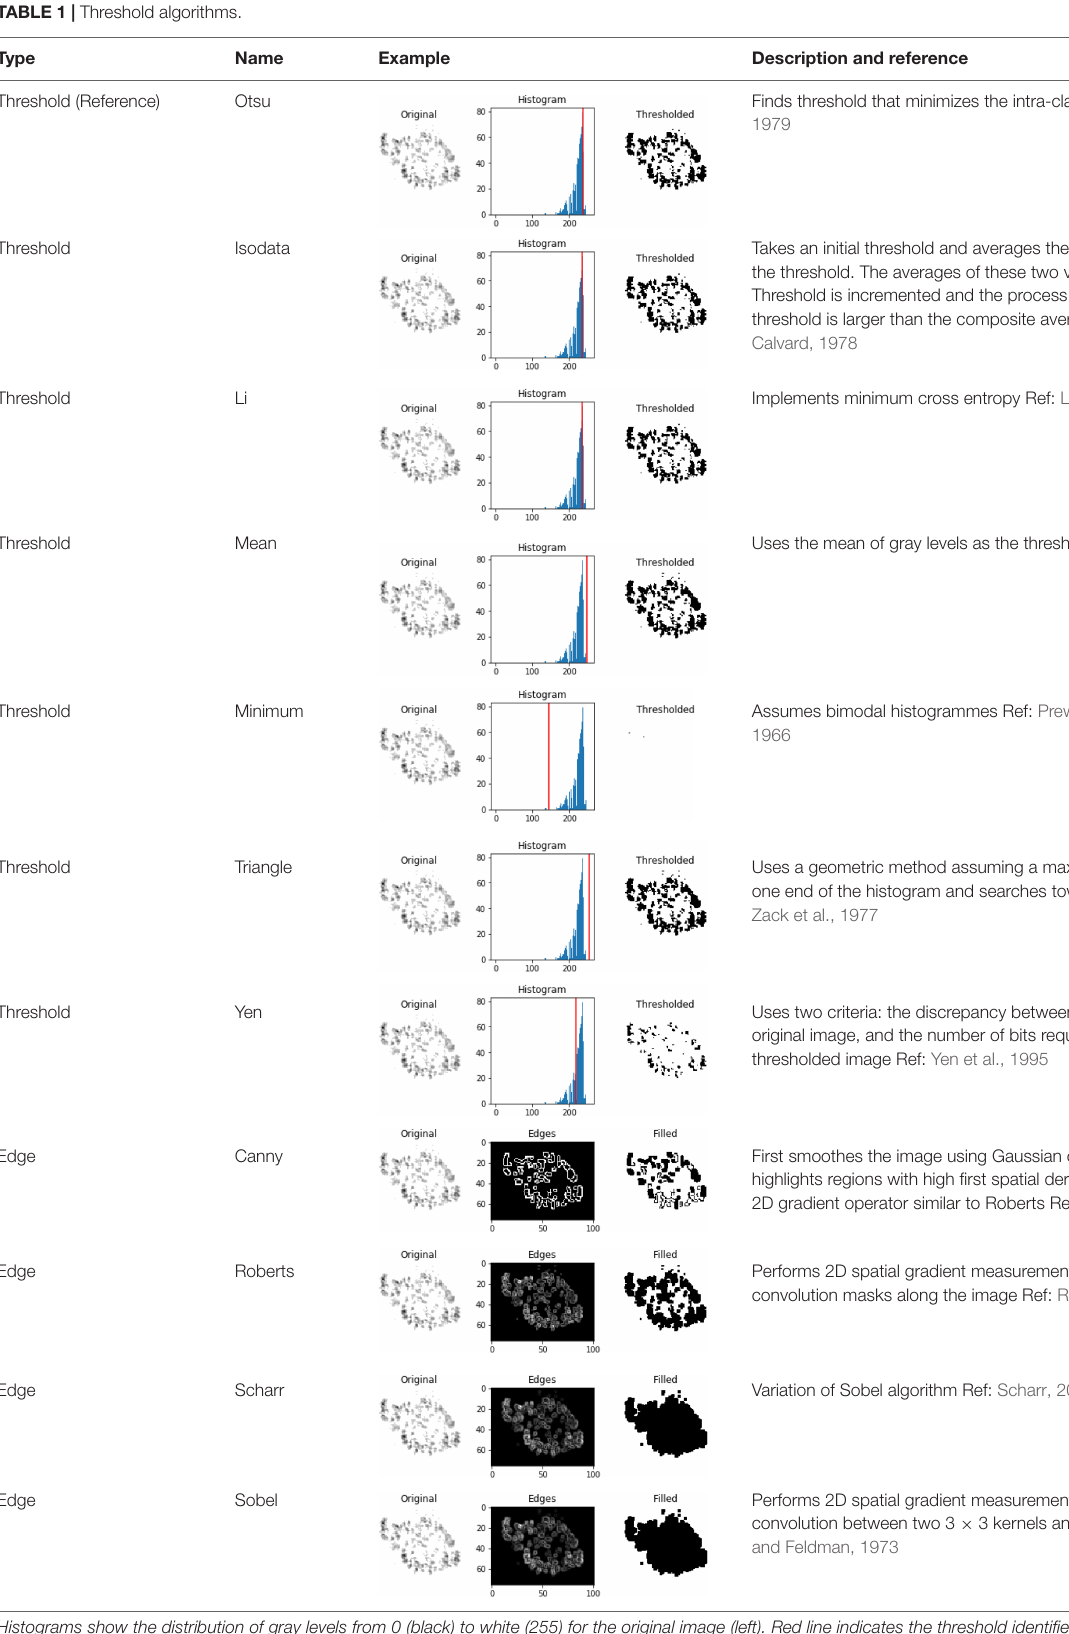
Histograms show the distribution of gray levels from 0 (black) to white (255) for the original image (left). Red line indicates the threshold identified by the algorithm, which is applied to generate the thresholded image (right). Frontiers in Marine Science |